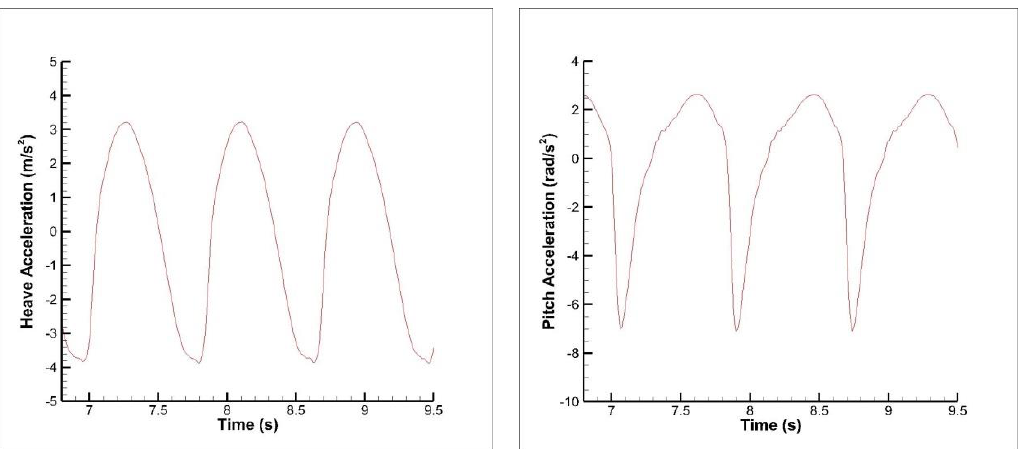
15 of 18 Figure 19. Frequency domain response of heave ( left ) and pitch ( right ) motions for C8, Fn B = 2.82, warped hull.